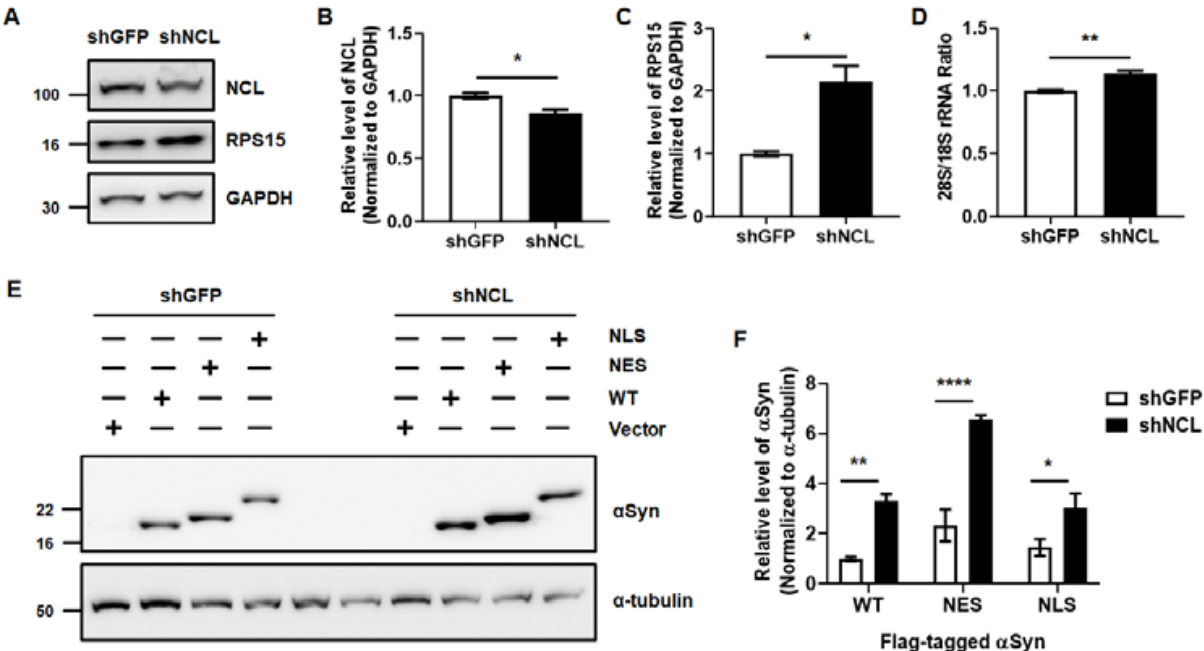
Figure 5. The reduction in NCL levels promotes α Syn accumulation. ( A – C ) The changes in NCL and RPS15 protein levels upon the transfection of shGFP and shNCL were analyzed. ( D ) 28S/18S rRNA ratio were analyzed using qPCR. Unpaired, two-tailed t-test was used for the comparison of results obtained from Western blot and qPCR analysis. ( E , F ) Following the transfection of various α Syn for 24 h, the sequential transfection of shGFP or shNCL for 24 h accelerated the accumulation of α Syn based on NCL levels in MEF. We used two-way ANOVA with Bonferroni’s post hoc test for analyzing the results obtained from Western blot analysis. Data are represented as the mean ± SEM. N = 3; * p > 0.05, ** p > 0.01, and **** p > 0.0001.